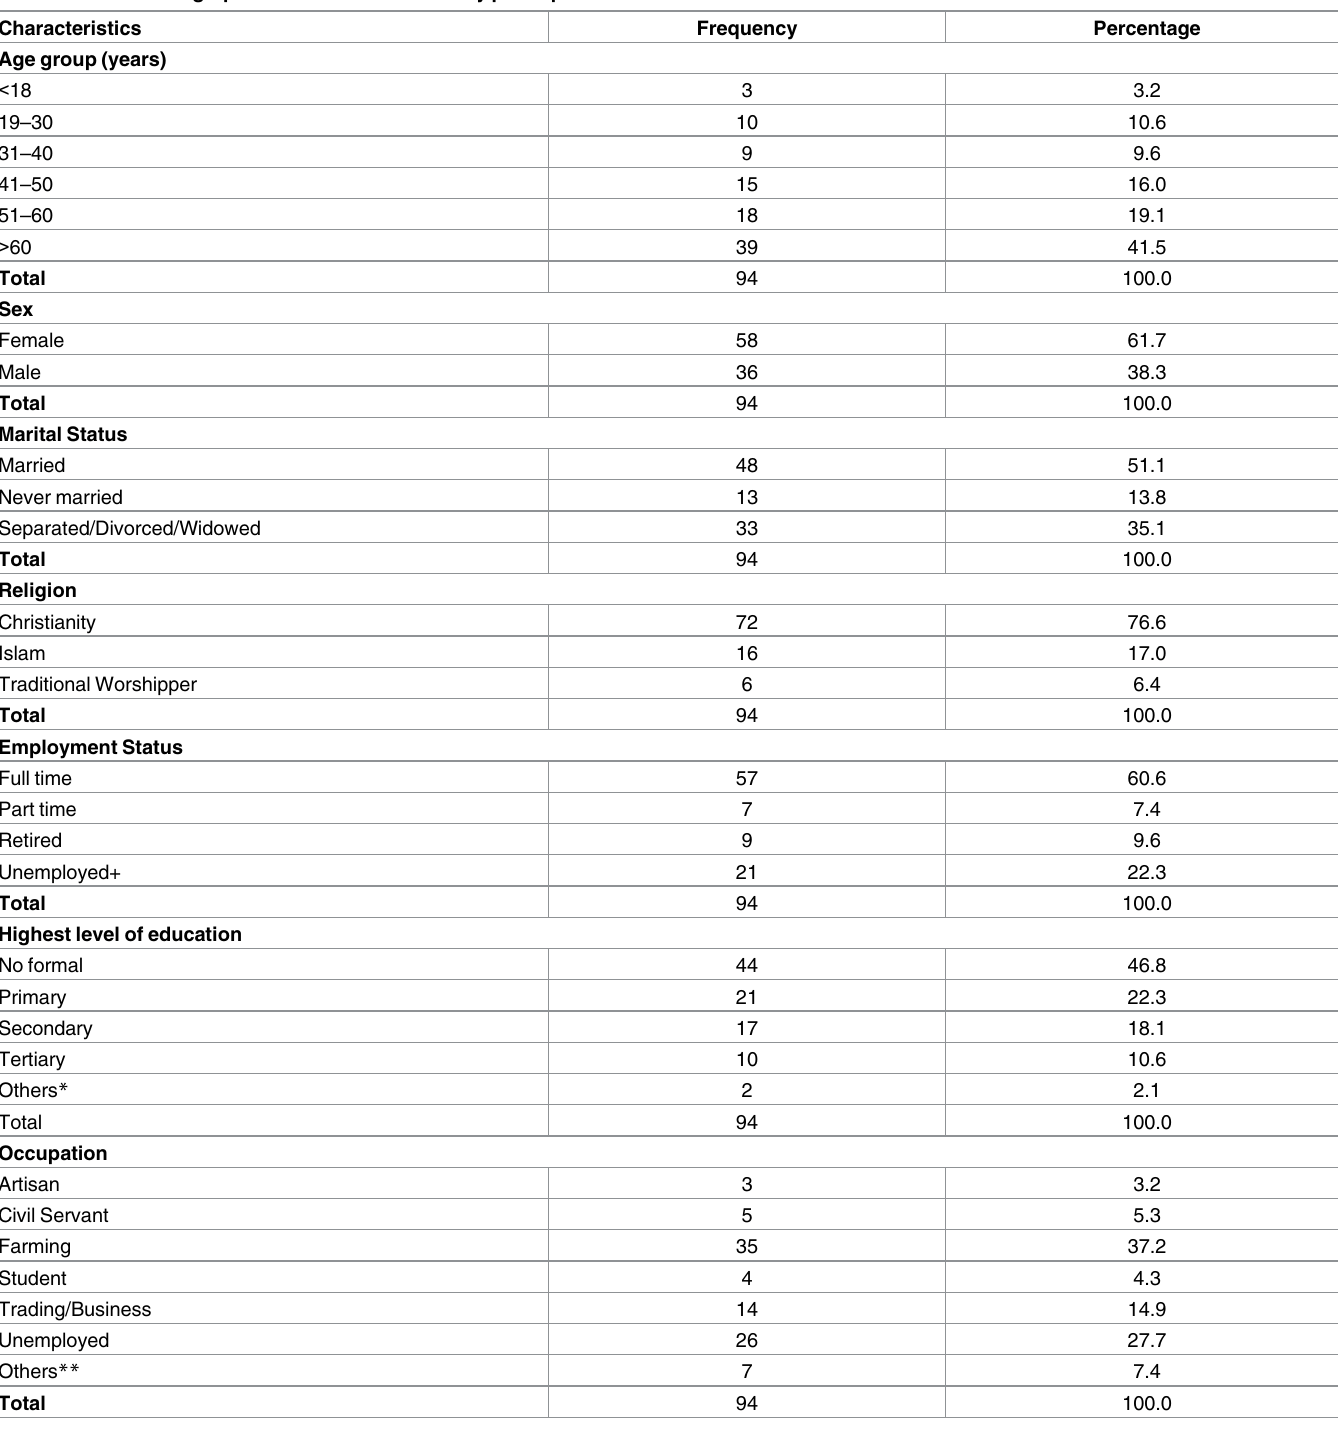
Table 1. Socio-demographic characteristics of study